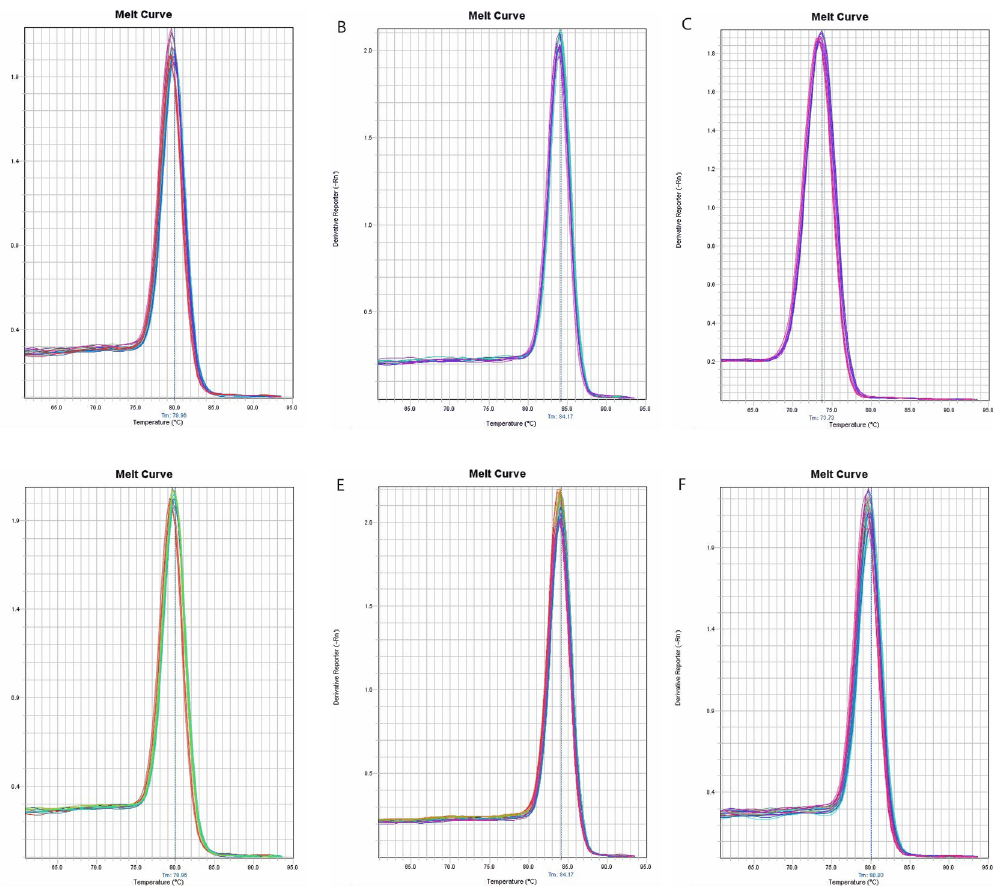
Figure 2. Melting curves. A: IL-10, the specific melting temperature was 79.96 u C; B: IL-12, the specific melting temperature was 84.17 u C; C: IL-16, the specific melting temper-ature was 73.73 u C; D: IL-17, the specific melting temperature was 79.96 u C; E: IL-18, the specific melting temperature was 84.87 u C; and F: IL-27, the specific melting temperature was 80.03 u C.